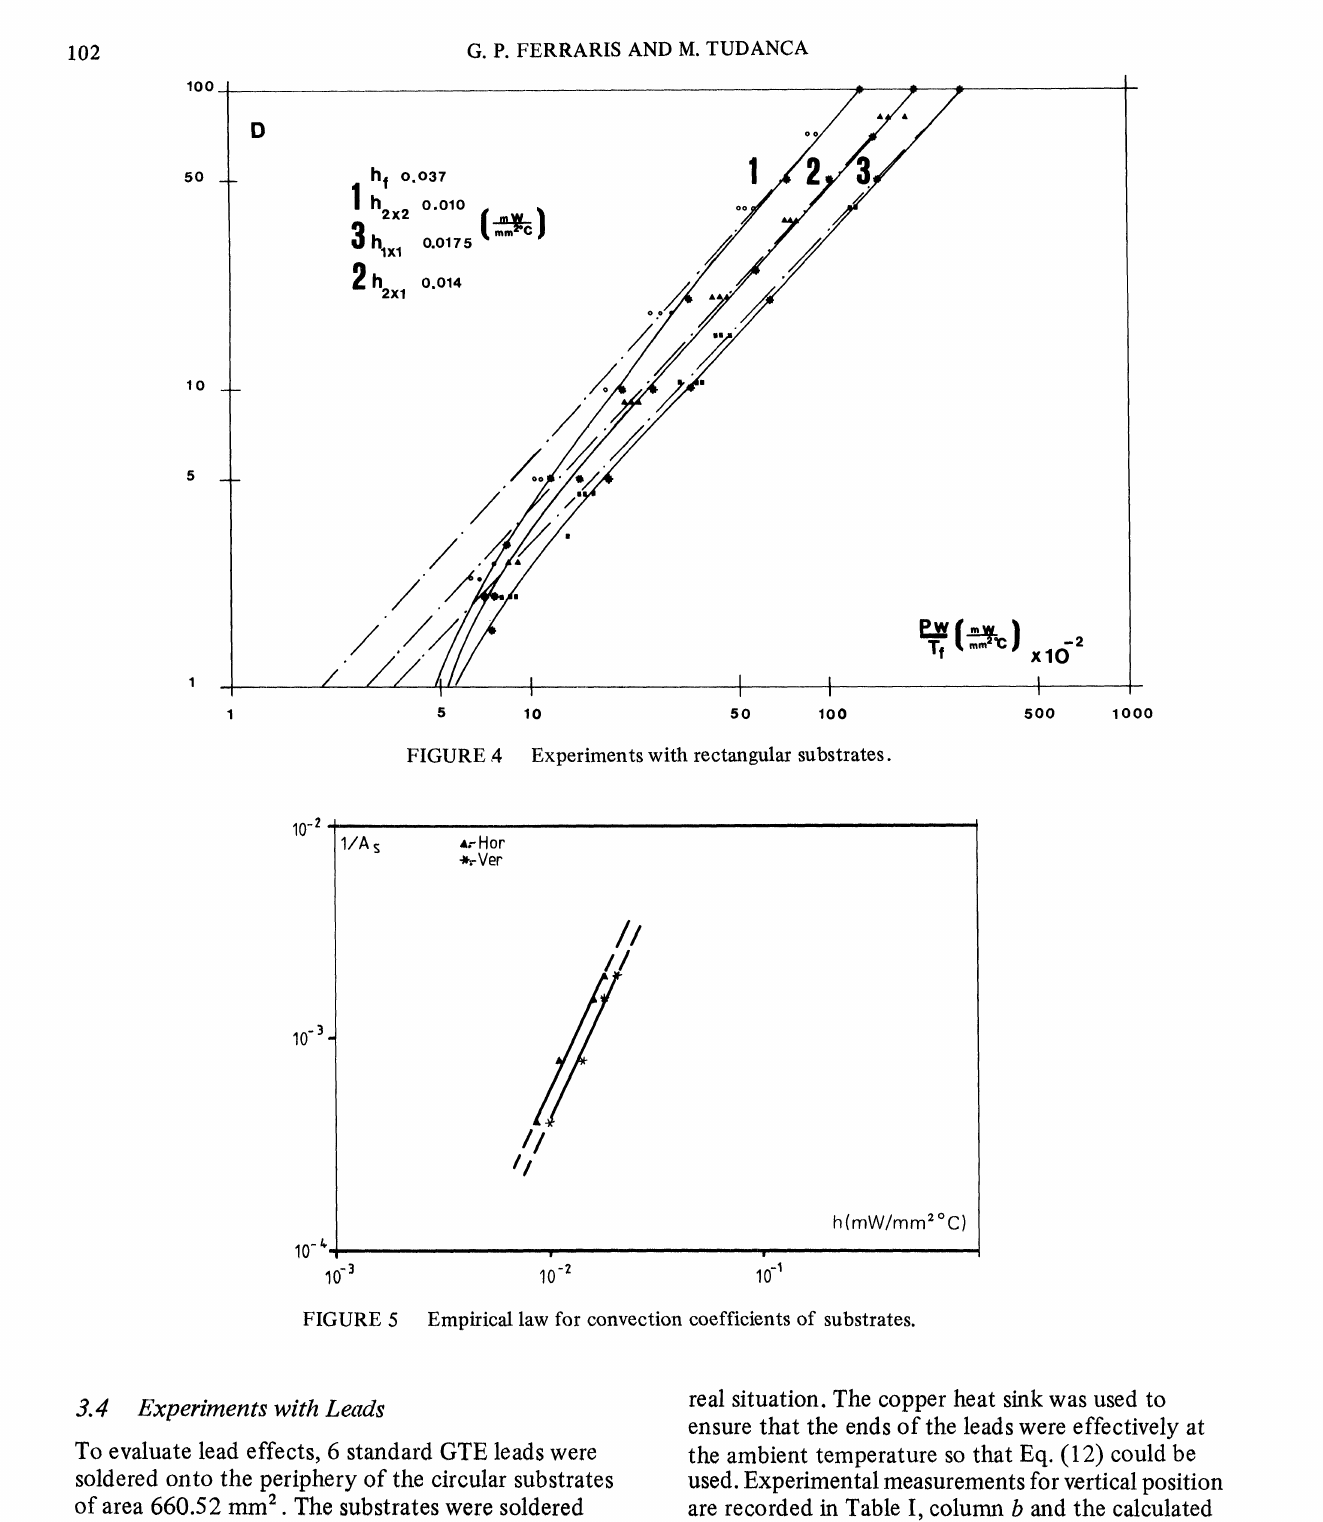
FIGURE 5 Empirical law for convection coefficients of